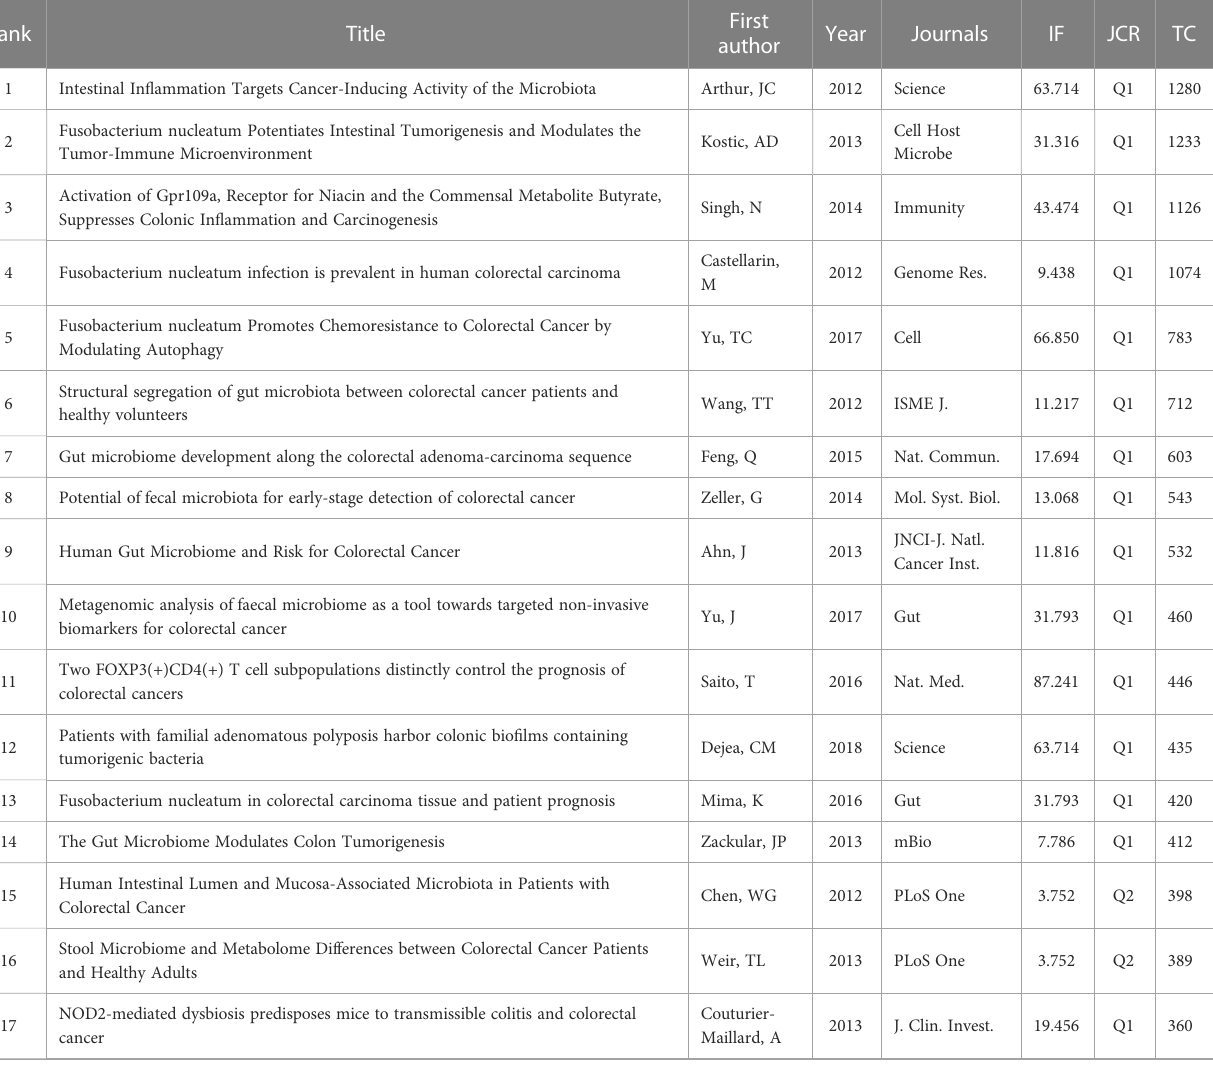
TABLE 5 The top 20 most cited original research in IM/CRC.